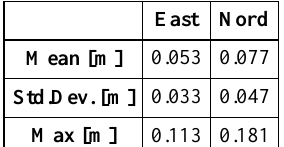
Table 2. Statistics of residuals on GCPs for NIR-RG survey on